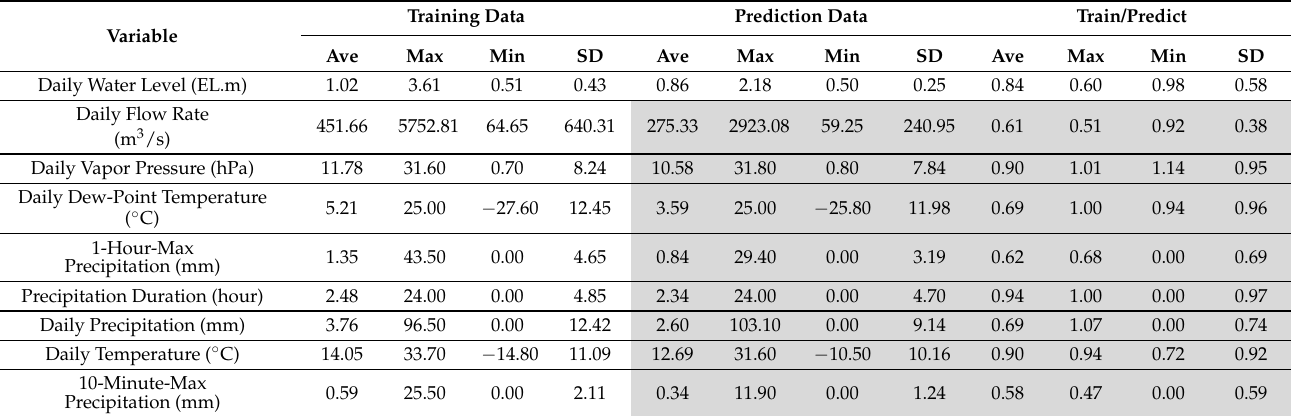
Table 4. Characteristics of hydrological and meteorological